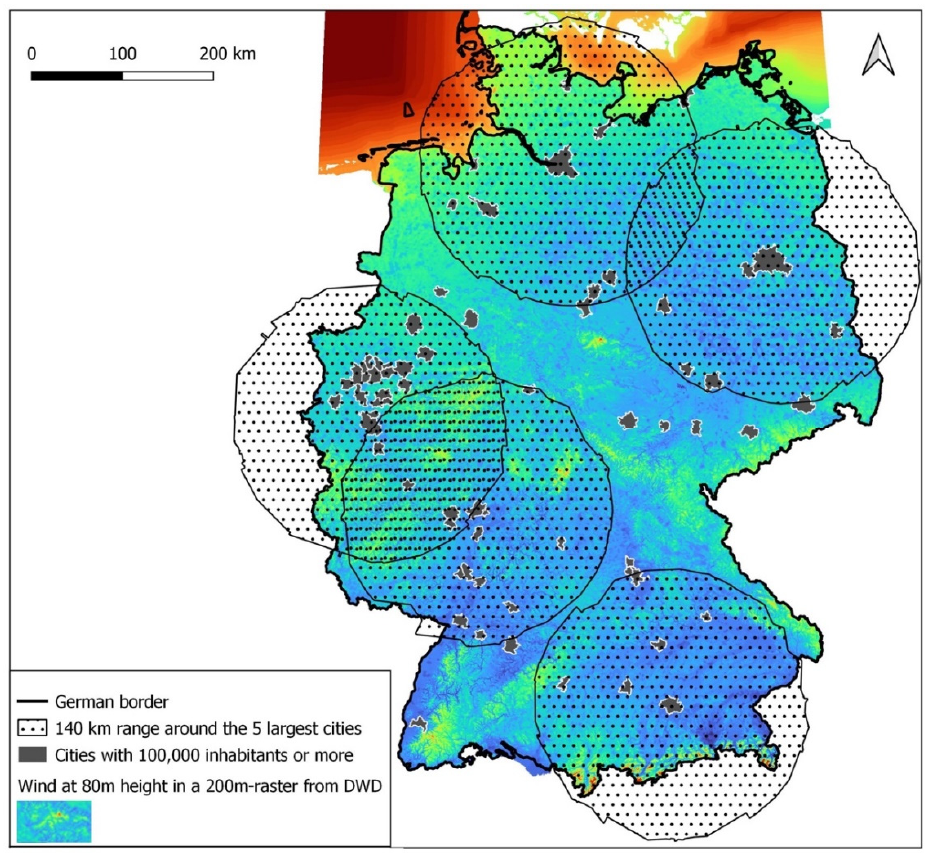
Figure 9. Average wind speeds in Germany at 80 m above ground.